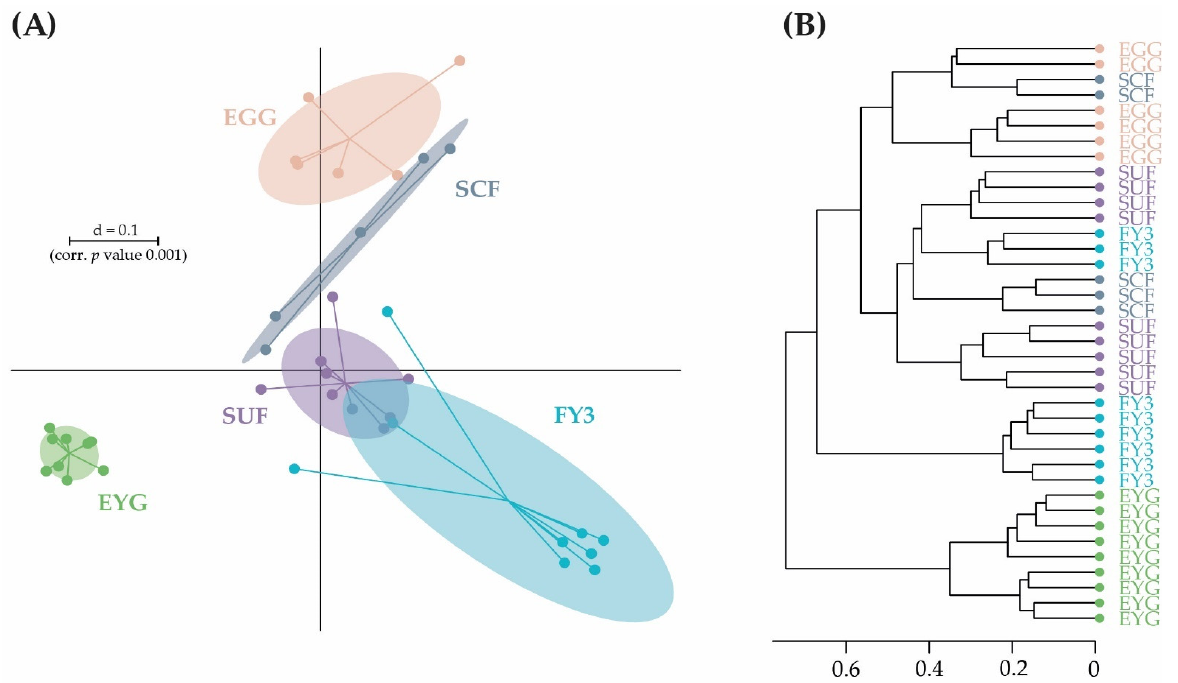
Figure 5. ( A ) β -diversity of early developmental stages. BC is shown as a multidimensional-scaling (MDS) plot. The scale is an indicator for the variation in the taxonomic makeup of microbiota between samples ( β -diversity) based on generalized UniFrac distances (d = 0.1 marks a 10% difference). ( B ) Dendrogram of samples from early developmental stages based on wards clustering method (d = 0.1 marks a 10% difference). EGG, egg; EYG, eyed egg; SCF, sac fry; SUF, swim-up fry; FY3, fry 82 dpf; dpf, days post fertilization.